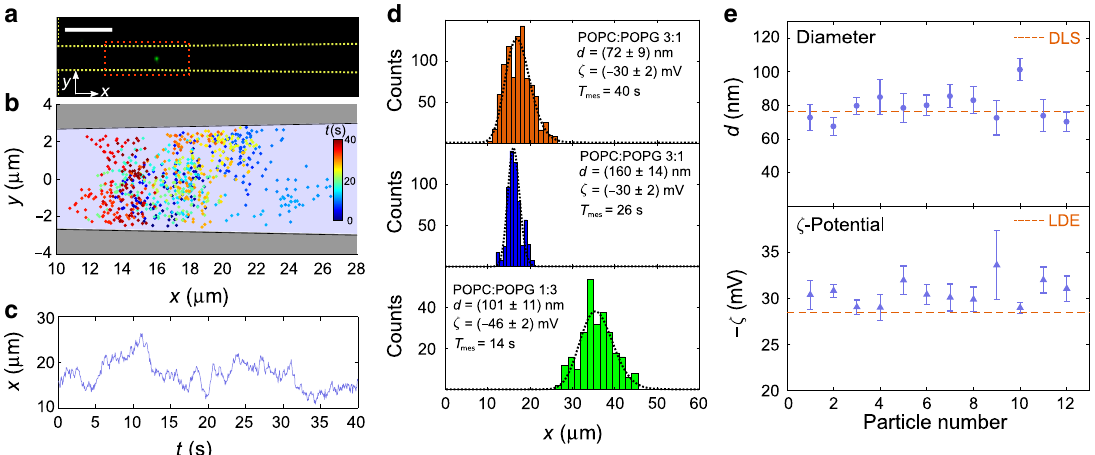
Fig. 2 Tracking a single, trapped particle. a Fluorescence microscopy image of a single, trapped liposome. Salt concentrations in the microchannels are − 3 × PBS and C fi xed at C C C = − 9.2. Scale bar is 10 μ m. b Measured positions in the nanochannel for the N equal to 10 W equal to 10× PBS, that is, ln( N / W ) area indicated with the red box in a . The particle is tracked for T mes = 40 s and imaged at 20 frames per second. c x -Coordinates versus time. d Histograms and fi tted distributions obtained from single-particle tracking of liposomes from three different populations with different diameters and zeta potentials. Upper panel corresponds to data in c . e Diameters and zeta potentials of individual particles from the POPC:POPG 3:1 population with d DLS = (76 ± 3) nm and ζ LDE = ( − 28 ± 1) mV. Results for particle no. 1 are from the the upper panel of d . Error bars are the standard deviations obtained from the fi ts to histograms in d